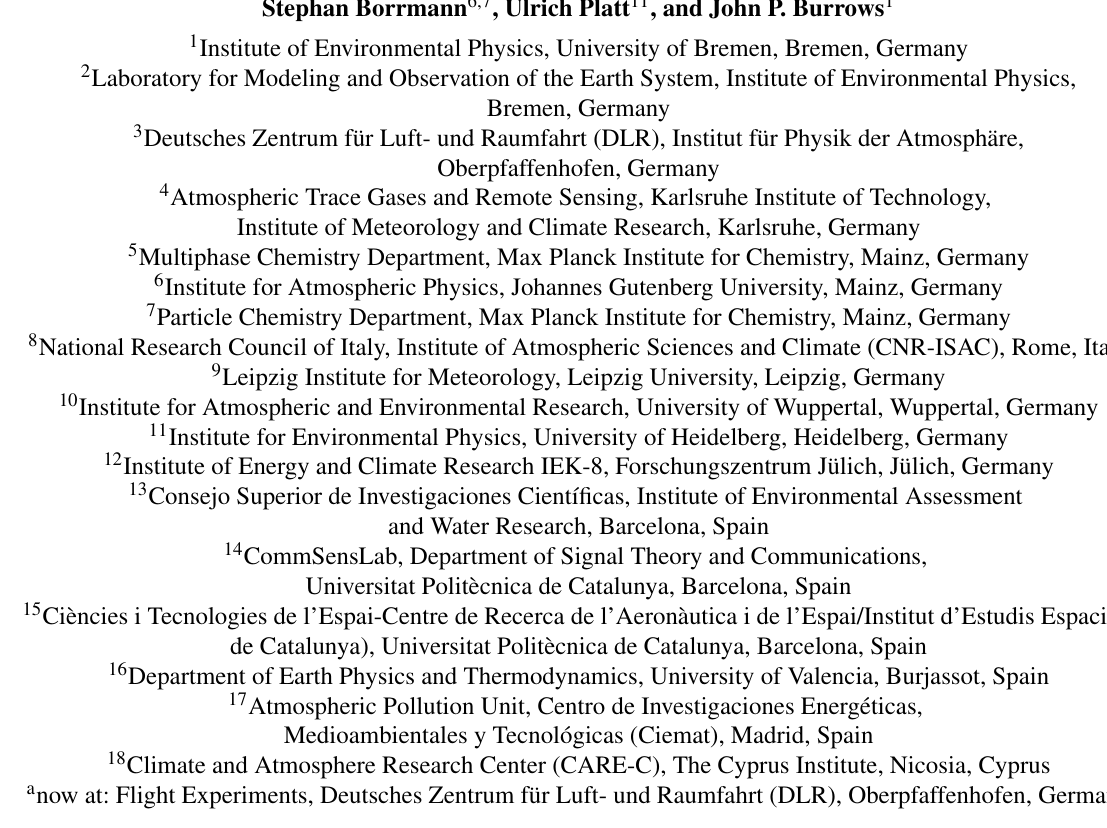
w Overview: On the transport and transformation